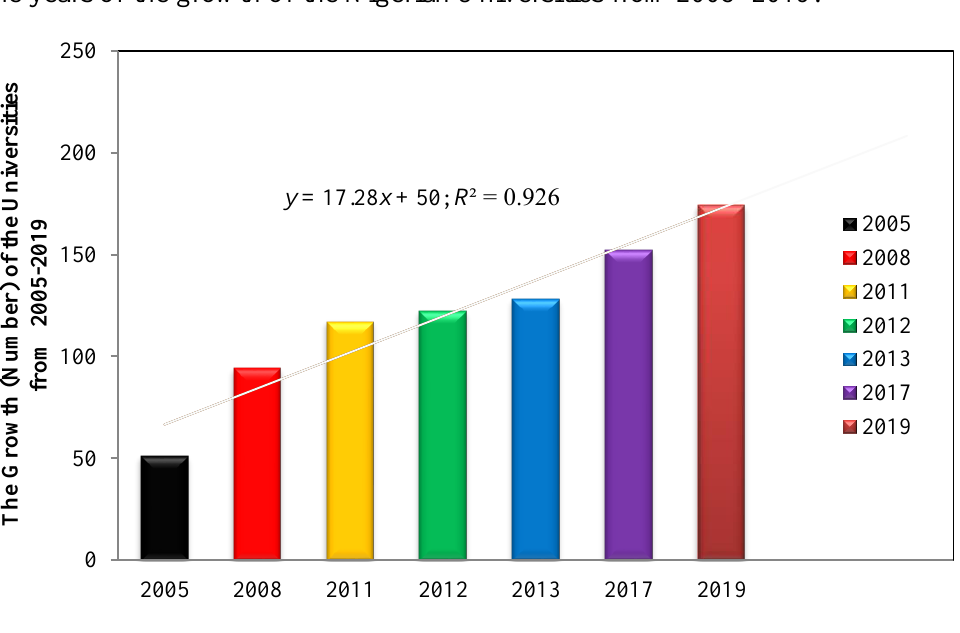
Fig. 2. The Years of the Growth of the Nigerian Universities from 2005–2019 (developed by the Authors, based on World Education Services and the National University